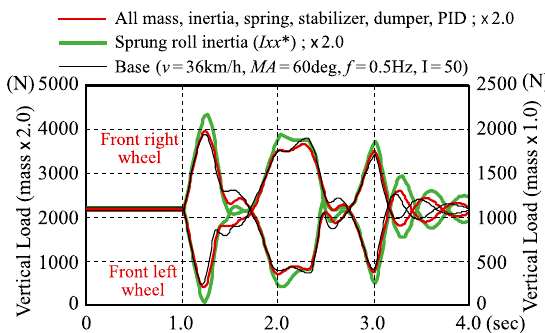
Figure 16. Equivalent roll dynamics gives same wheel lifting phenomena.